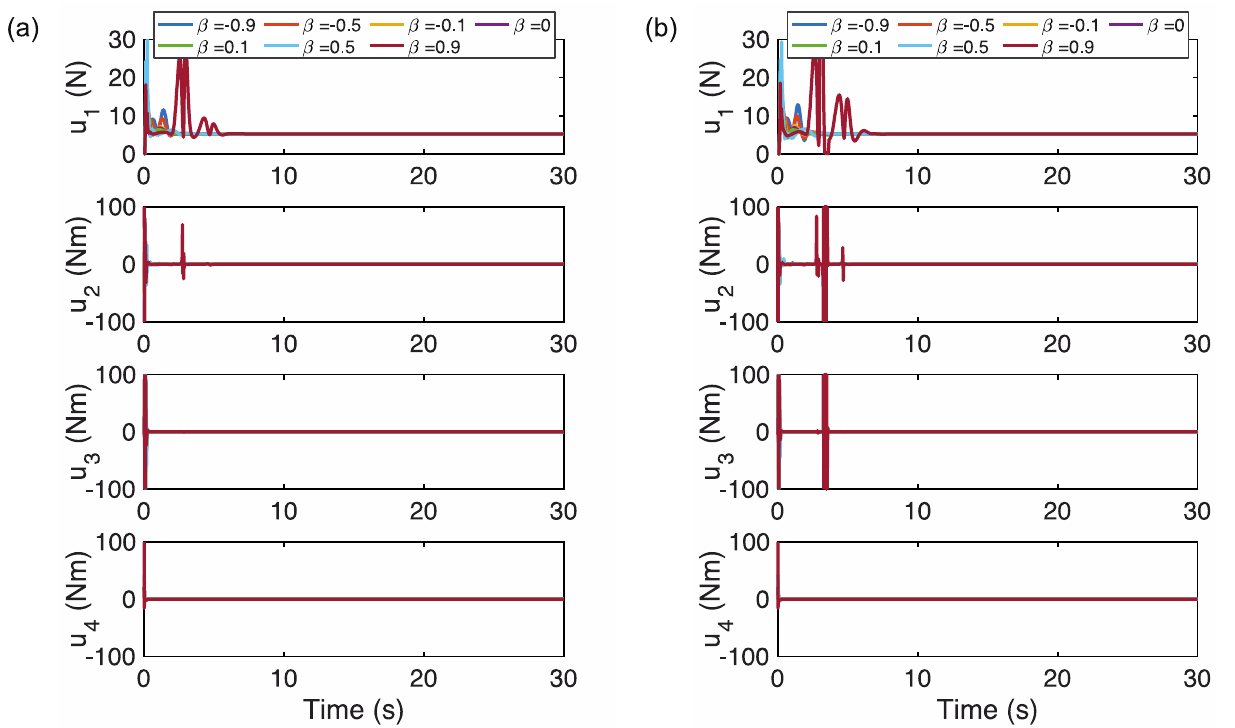
be ensured at larger positive β values, as shown in Theorem 1.